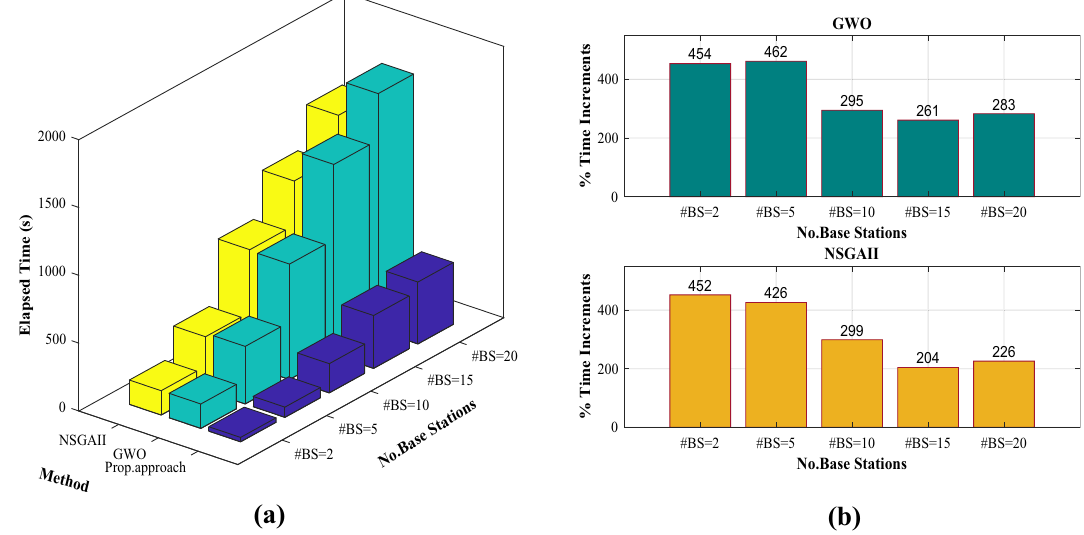
Figure 11. The total computational time consuming (10 separate repetitions) for robust optimal positioning of different sizes of base statements (number of transmitters), ( a ) time elapsed using each method, ( b ) percent increment of time elapsing for standalone GWO and NSGAII compare with proposed hybrid Kriging/GWO